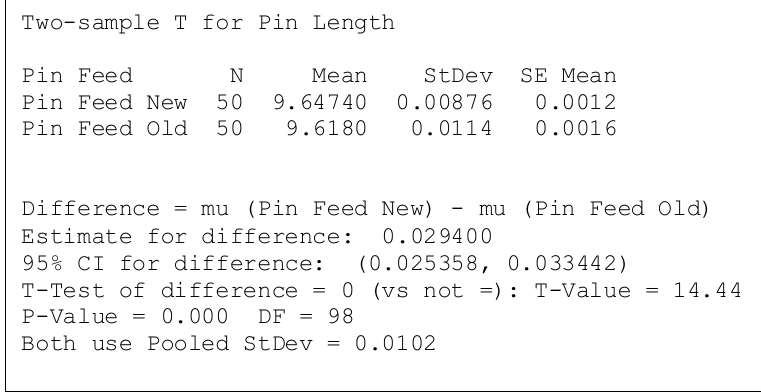
Sample 1: Improved pin feeder device Sample 2: Existing pin feeder device